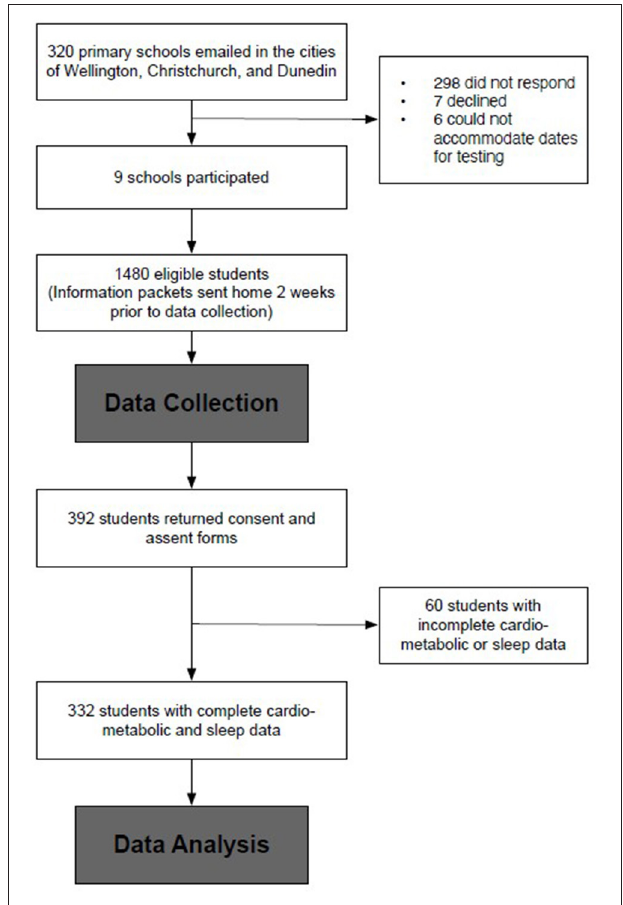
FIGURE 1 | Student recruitment flow